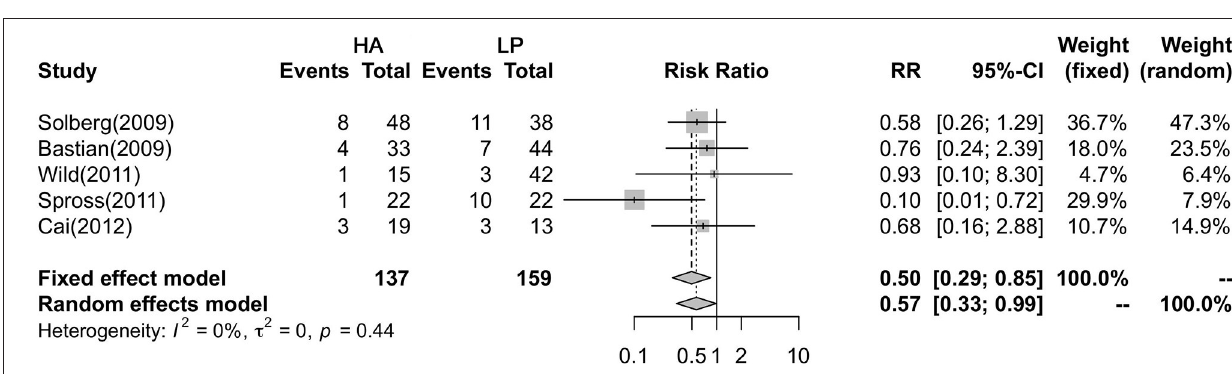
FIGURE 3 | Forest plot showing the meta-analysis of the reoperation